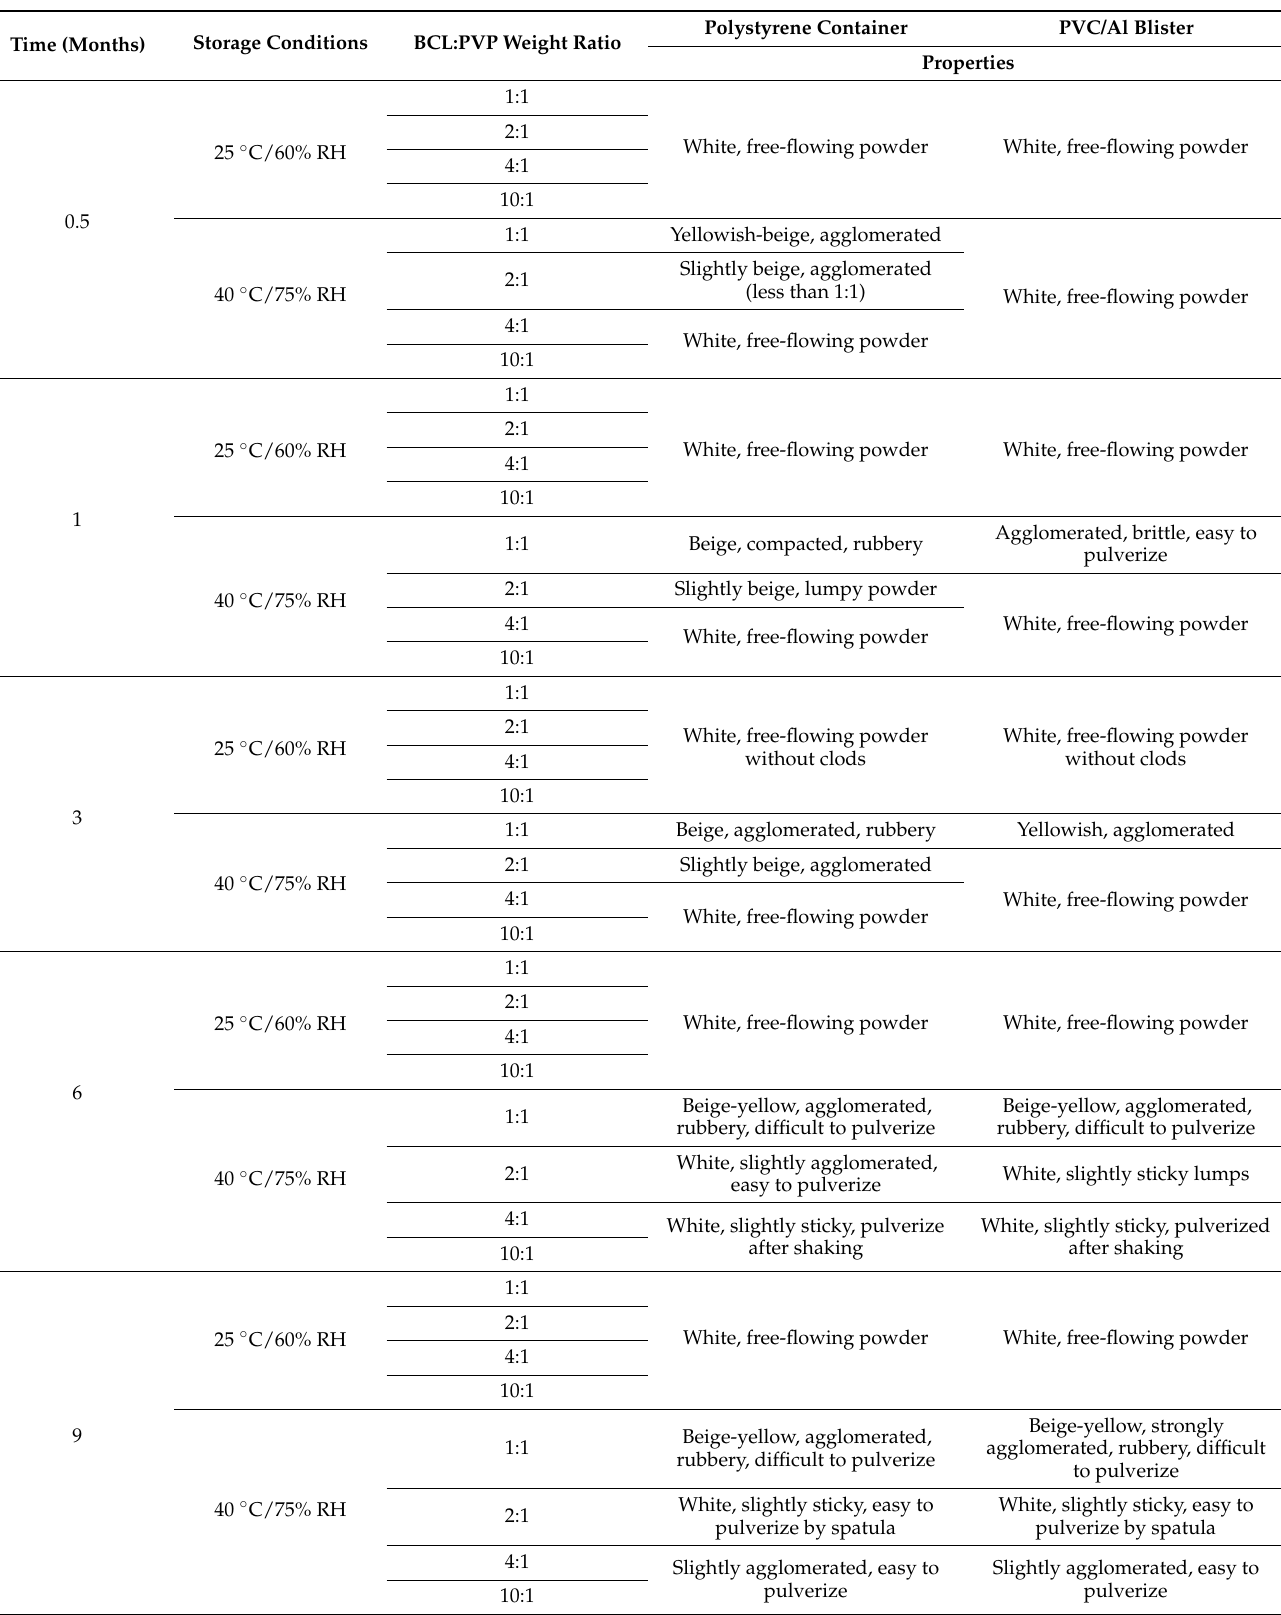
Table 1. Appearance of BCL:PVP solid dispersions after